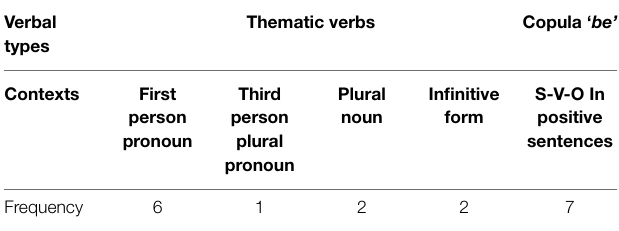
TABLE 7 | Overgeneralization of 3SG markings for the two tasks.